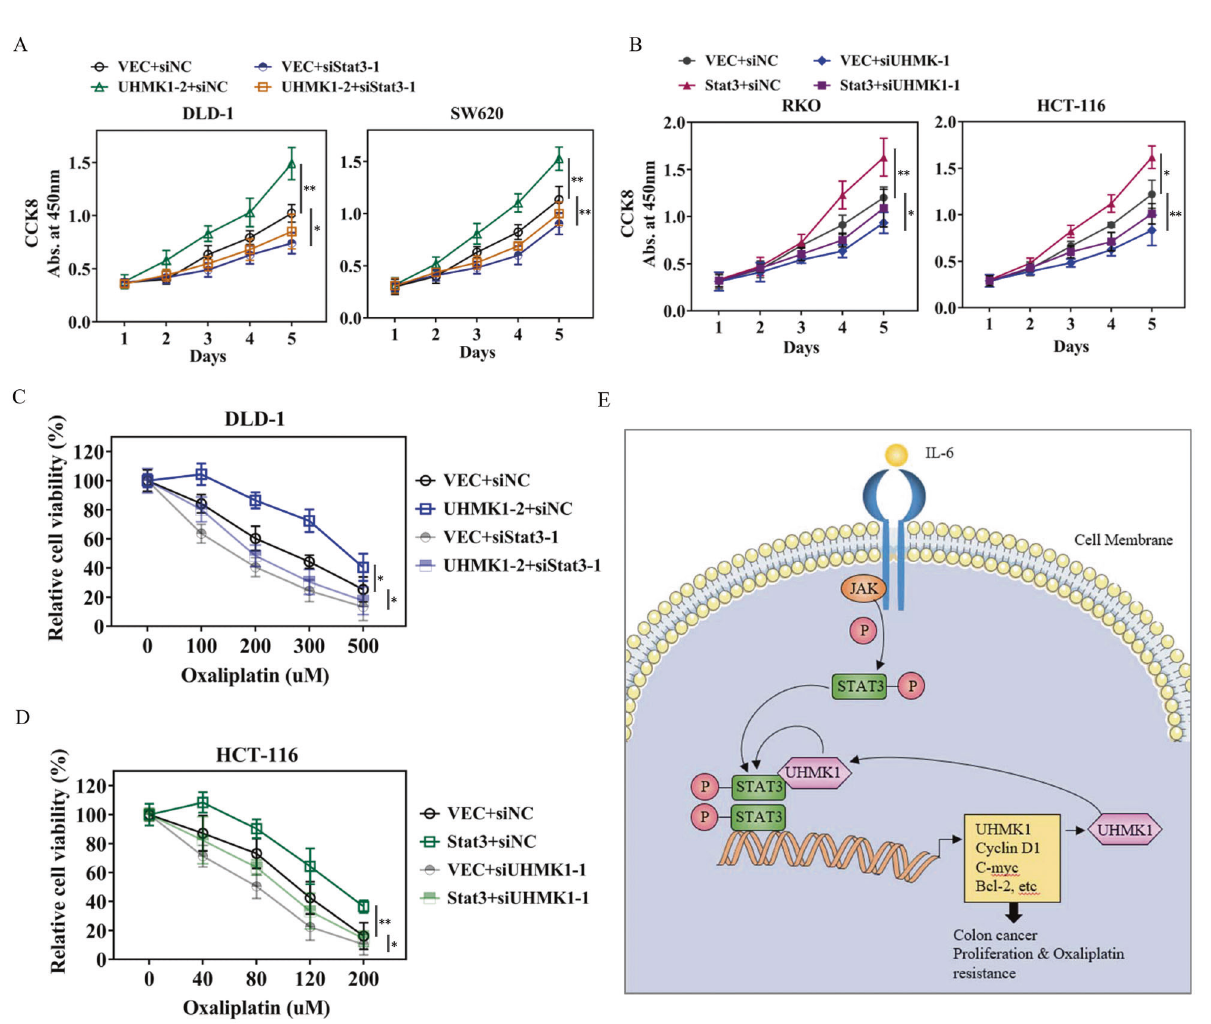
Fig. 6 The functional relationship between UHMK1 and STAT3 in regulating cell proliferation and oxaliplatin resistance. A Cell viability was measured by CCK-8 assay in DLD-1/UHMK1-2 or SW620/UHMK1 cells with or without STAT3 knockdown. B CCK-8 assay in RKO and HCT- 116 cells transfected with si-NC, siUHMK1-1, empty vector or STAT3 plasmid in a combined way as indicated. C Cell viability was measured by CCK-8 under gradient oxaliplatin treatment using cells as indicated in ( A ). D Cell viability was measured by CCK-8 under gradient oxaliplatin treatment using cells as indicated in ( B ). * p < 0.05, ** P < 0.01. E Schematic diagram of the positive feedback loop between UHMK1 and